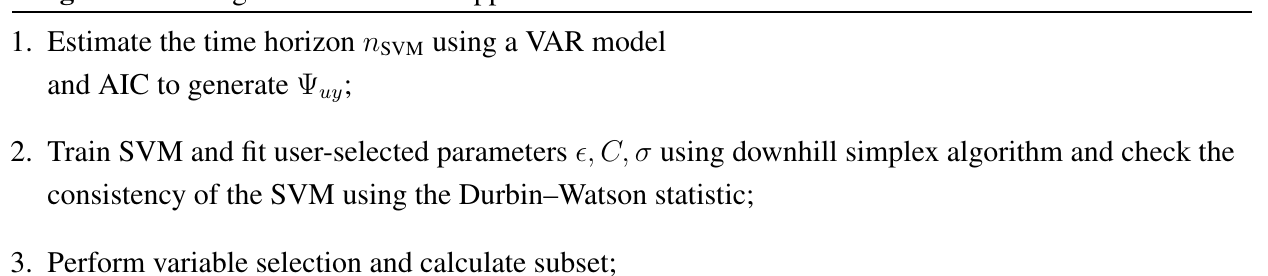
Algorithm 4: Algorithm based on support vector